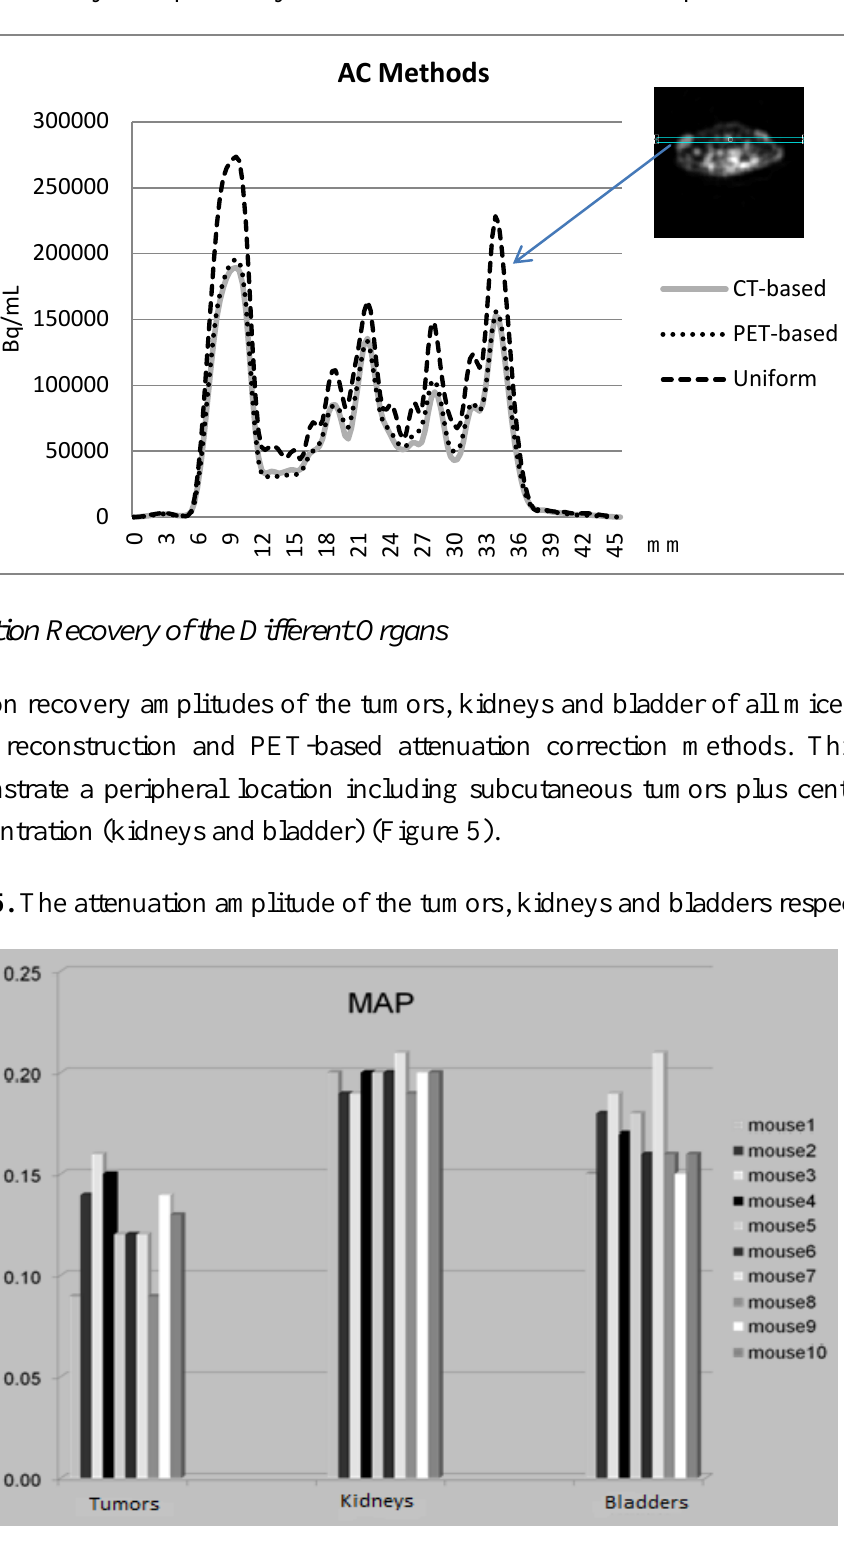
Figure 4. The activity profile was applied on the MAP reconstructed CT-based images PET-based and the uniform attenuation map respectively. The vertical axis of the profile is showing the activity in Bq/ml unity while the horizontal axis is the spatial distance in mm.